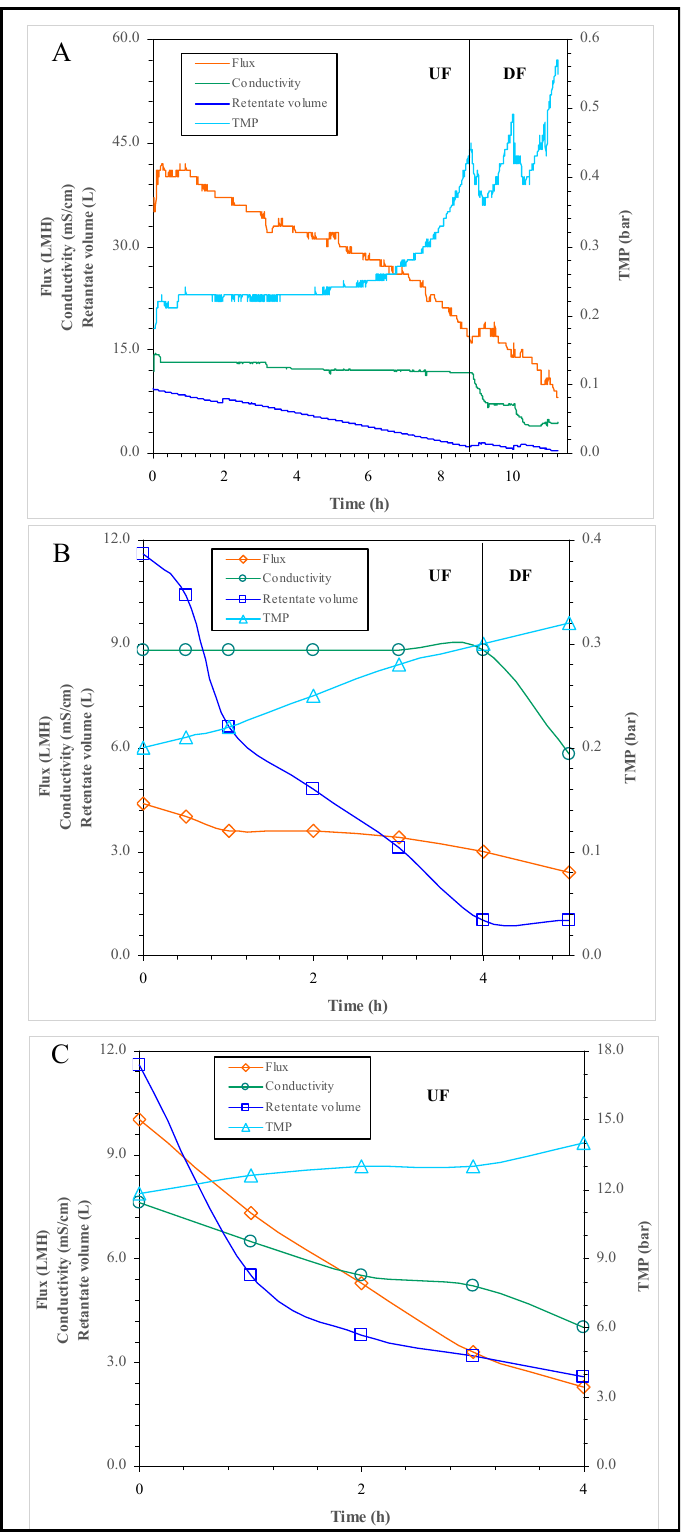
Figure 2. γ -PGA ultra-filtration (UF) and dia-filtration (DF) phases of 100 kDa ( A ), 3 kDa ( B ) mem- brane processes and the ultra-filtration phase of the nano-filtration purification ( C ), as indicated in the graphs. The curves of TMP, flux, conductivity and retentate volume during the processes are